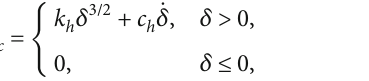
Figure 1. Under external force, the descending object moves relative to the ascending object at a certain speed to simulate the collision environment. As a result, the metal tube sand- wiched between them is compressed and deformed.